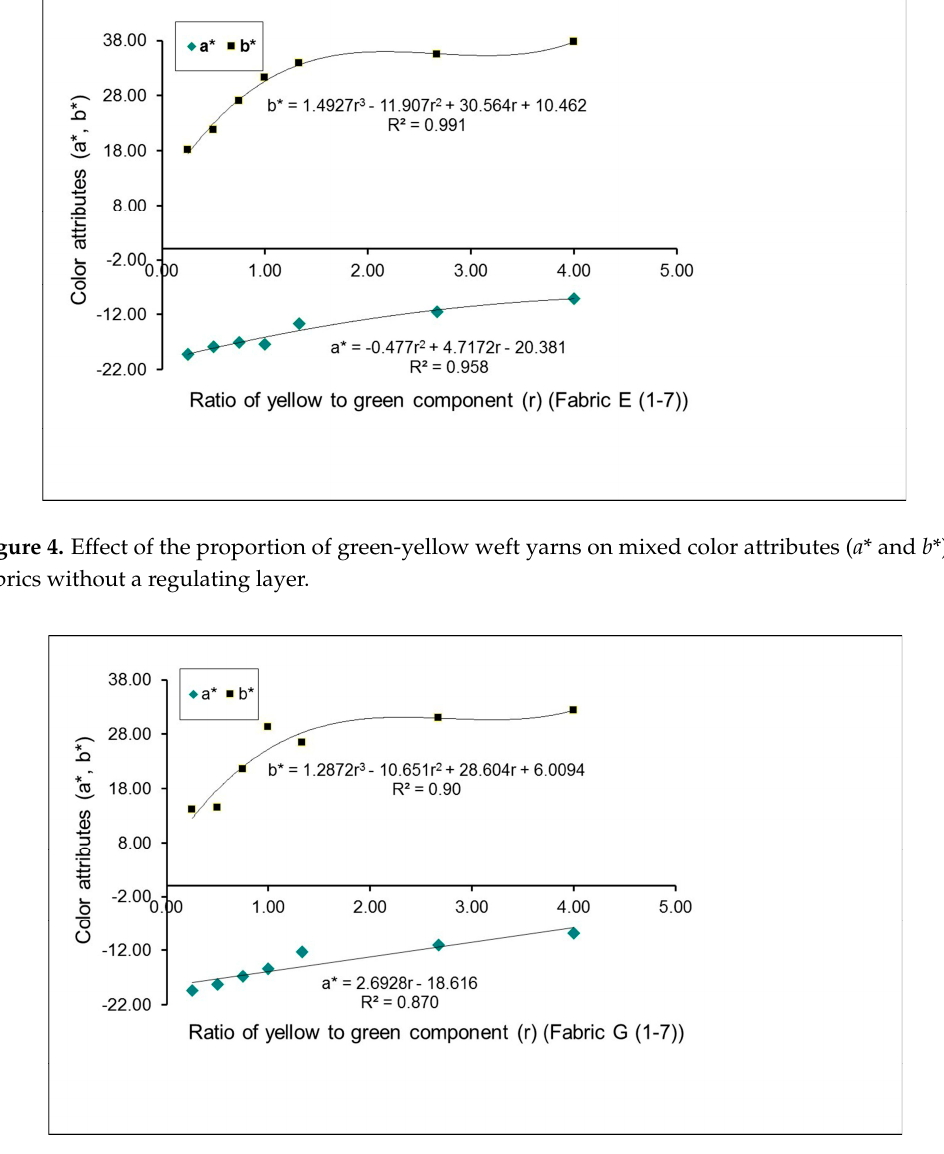
Figure 5. Effect of proportion of green-yellow weft yarns on mixed color attributes ( a * and b *) of fabrics with a regulating